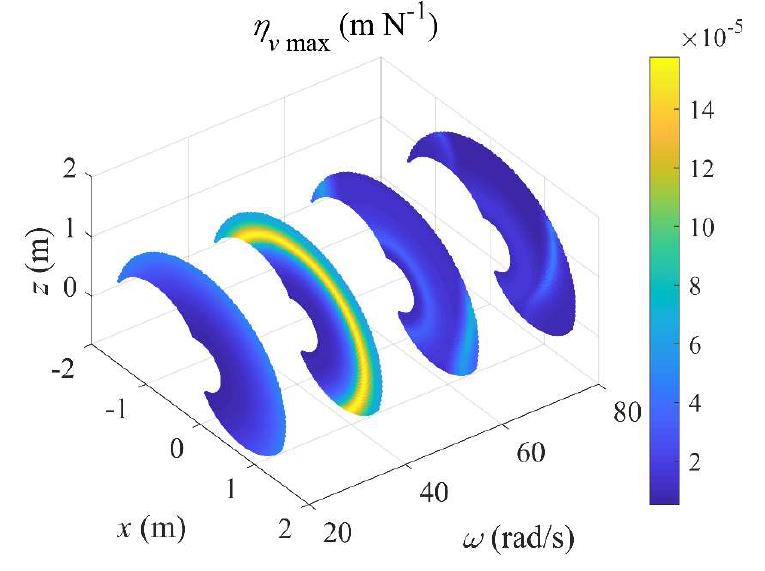
Figure 6. Distribution of η υmax over robot workspace.